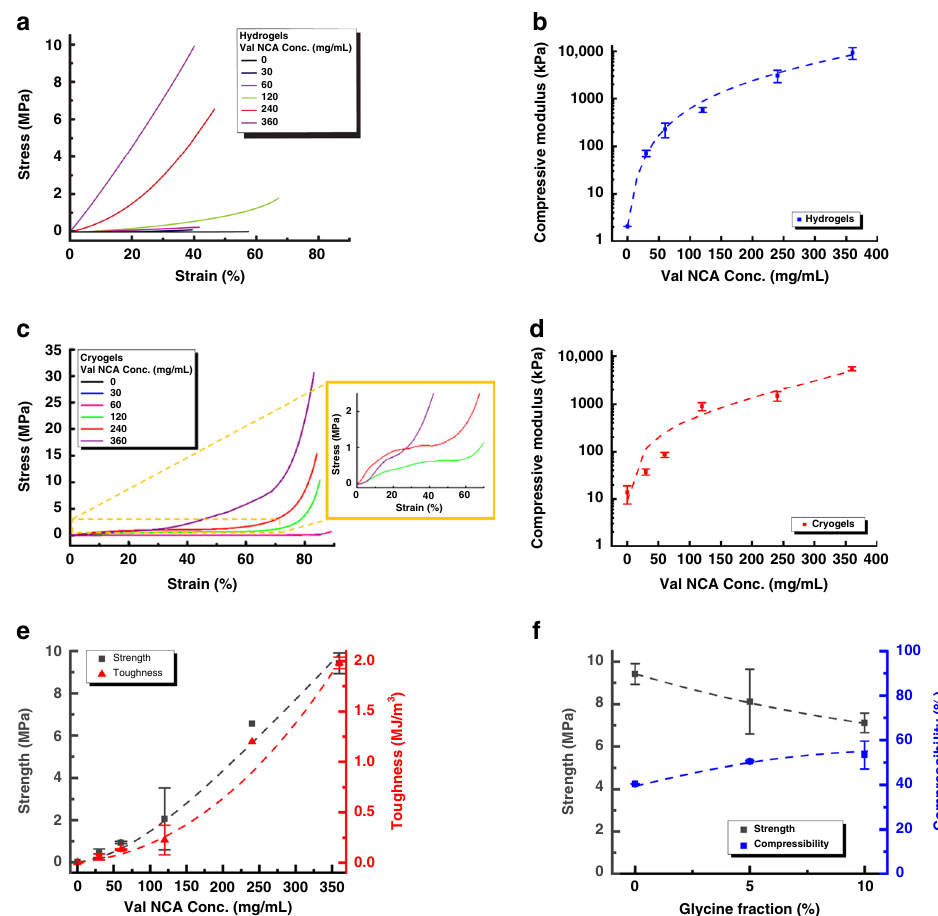
Fig. 6 Mechanical properties summary of β -sheets-incorporated networks. Networks obtained using different Val NCA monomer concentrations (0~360 mg/mL): a , c Compression strain-stress curves of hydrogels and cryogels respectively; b , d Compression moduli (stiffness) of hydrogels and cryogels respectively, as a function of Val NCA monomer concentrations; e Strength and toughness of hydrogels; f Strength and compression at break (compressibility) of hydrogels with glycine inclusion. All error bars represent standard deviation ( n = 3).